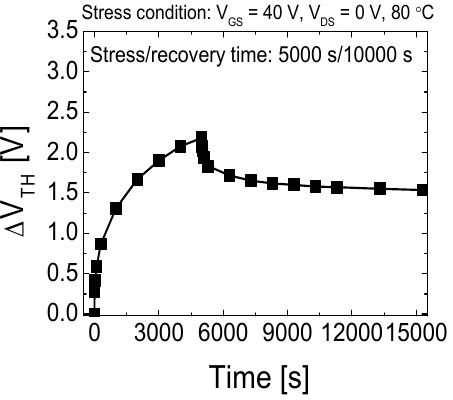
Figure 4. Time evolution of Δ V TH during the stress ( V GS = 40 V, V DS = 0 V, 80 °C, t st = 5000 s) and subsequent recovery ( V GS = 0 V, V DS = 0 V, 80 °C, t st = 10,000 s)